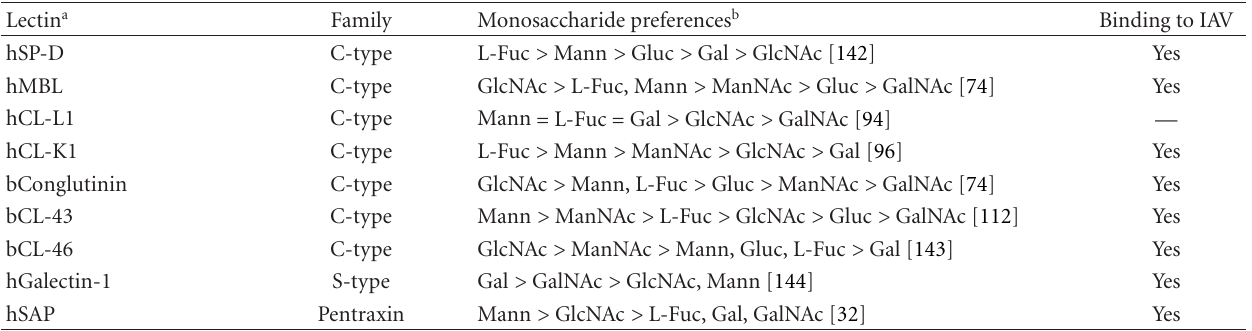
Table 1: Comparison of monosaccharide specificity of animal lectins with anti-IAV